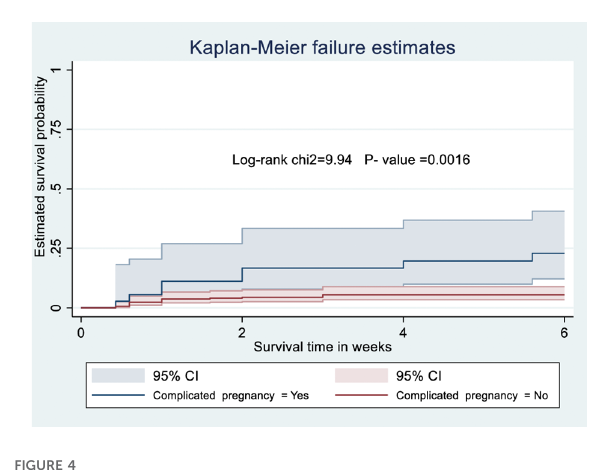
FIGURE 4 Kaplan-Meier curve showing the survival probability of developing puerperal sepsis among postnatal women based on pregnancy condition.